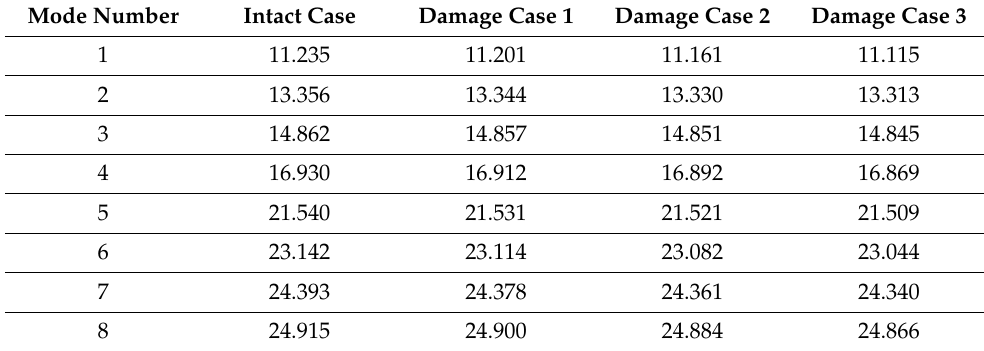
Table 5. Natural frequencies of modes for RC-slab-bridge